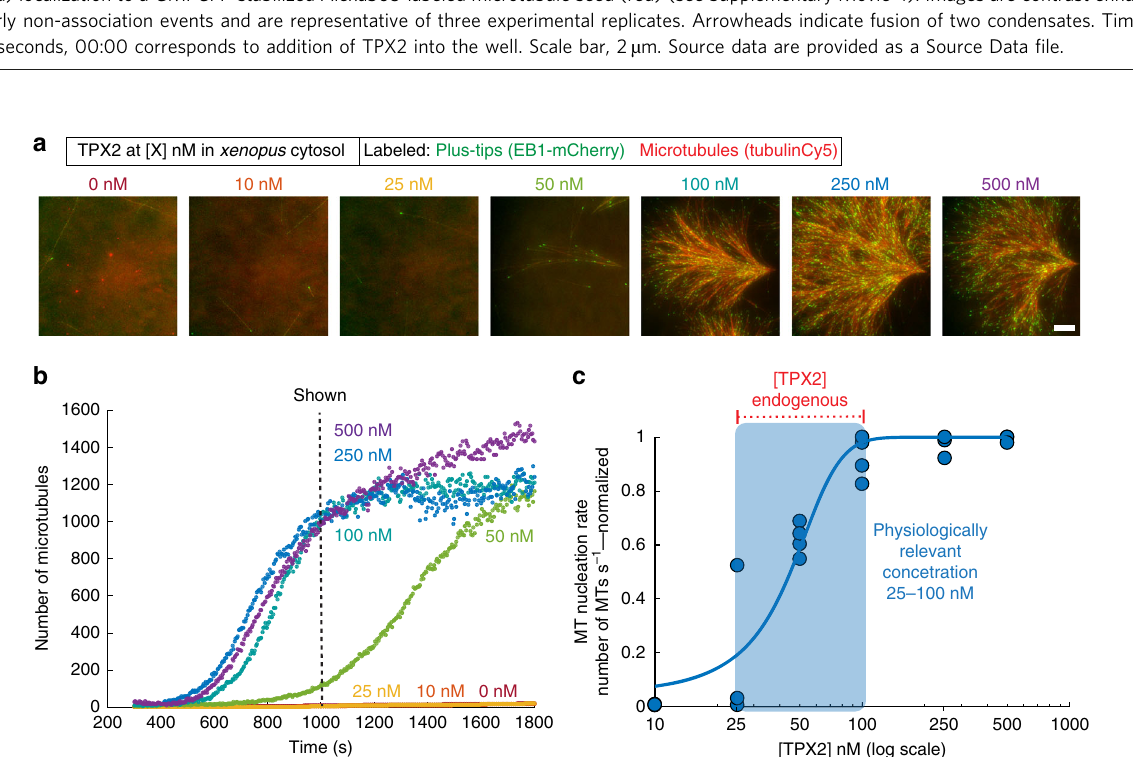
Fig. 3 TPX2-tubulin co-condense at the physiologically relevant concentration of TPX2. a TIRF images and b quanti fi cation of TPX2-mediated branching MT nucleation in Xenopus meiotic cytosol at indicated concentrations of TPX2. Shown images were taken at 1000s (indicated). Cy5-labeled tubulin (red) and mCherry-EB1 (green) highlight microtubules and growing microtubule plus ends, respectively. Scale bar, 10 µ m. See also Supplementary Movie 5. c Rate of MT nucleation as a function of TPX2 concentration for four independent replicates of data shown in a and b . Source data are provided as a Source Data fi le. See also Table 1. Rates normalized to maximum rate within an experiment. Line of best fi t shown and approximate physiologically relevant range (25 – 100 nM) highlighted. Endogenous concentration range of TPX2 (30 – 100 nM) indicated (also in Fig.